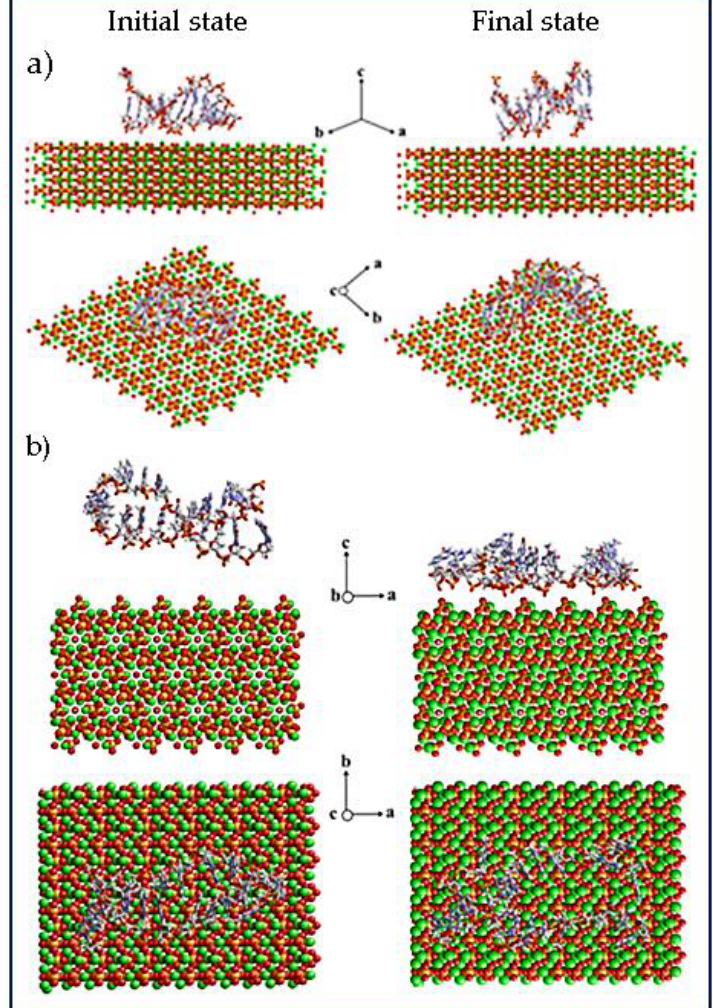
Figure 12. Snapshots showing the double helix of DNA adsorbed at the (001) ( a ) and (010; Ca 2+ ) ( b ) surfaces of the HAp hexagonal unit cell with P 6 3 / m geometry ( a = b = 0.9421 nm, c = 0.6881 nm) at the beginning ( left ) and the end ( right ) of the 15 ns isothermal-isobaric ensemble (NPT) molecular dynamic simulations. Reproduced with permission from [127], Royal Society of Chemistry, 2014.